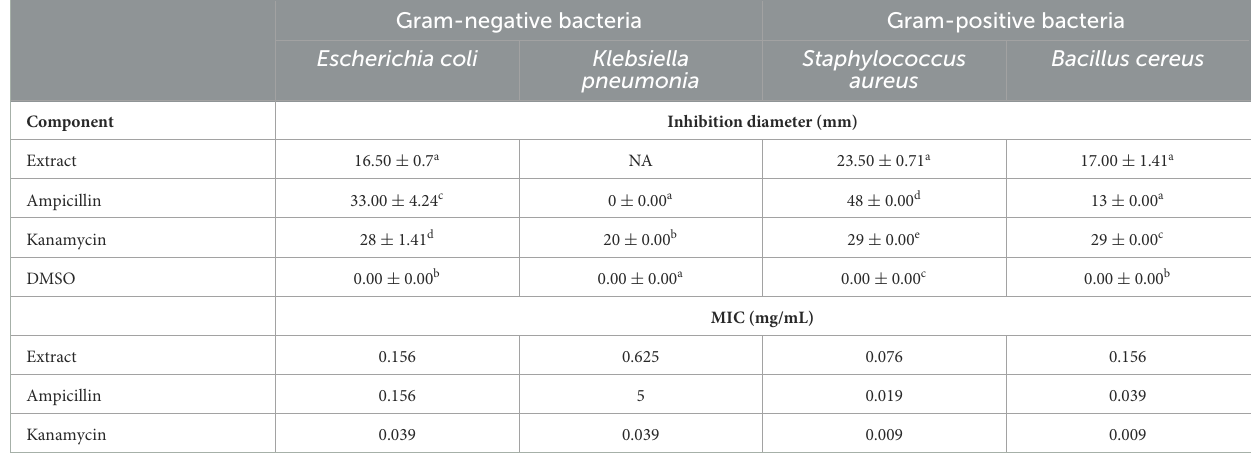
TABLE 6 Minimum inhibitory concentration (MIC) and inhibition diameter of aqueous extract of Polygonum equisetiforme roots. Gram-negative